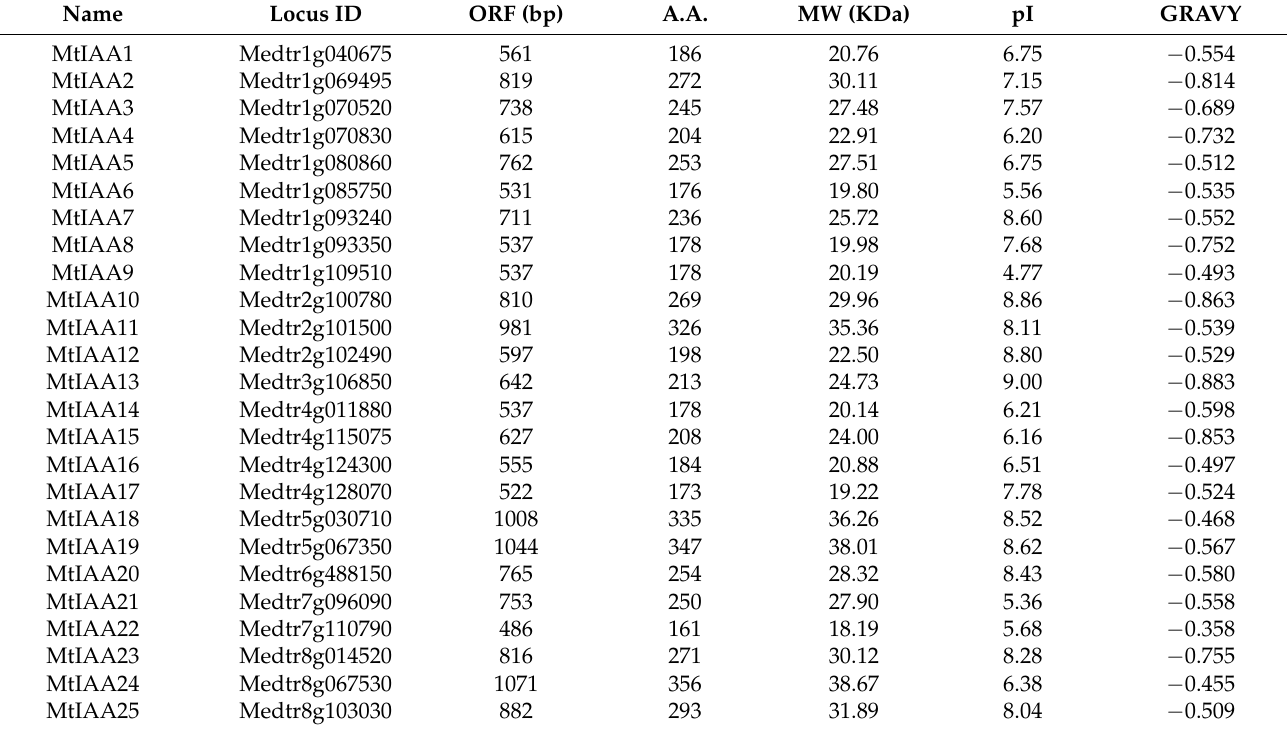
Table 1. Information on MtIAA proteins.